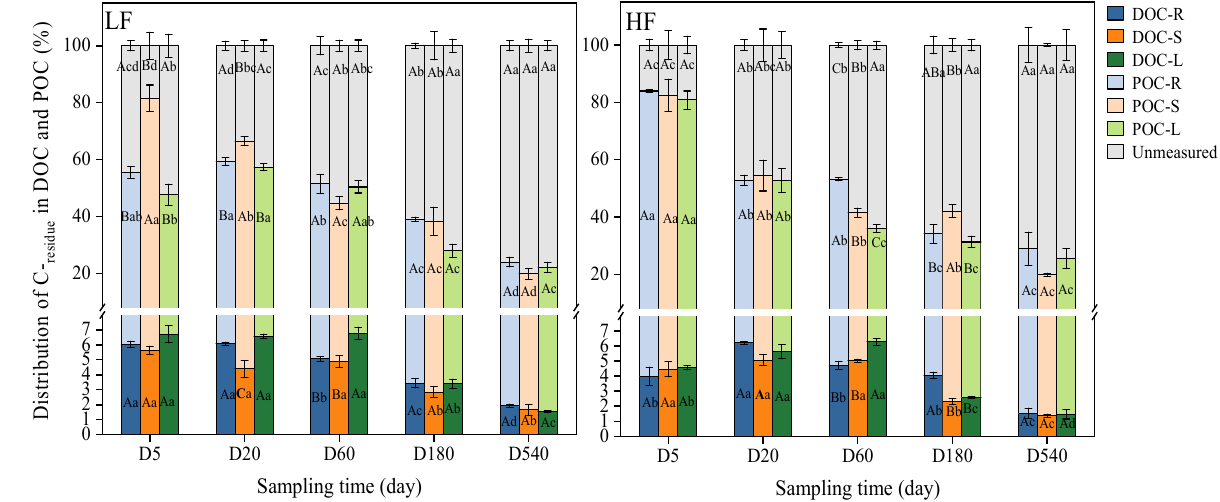
Figure 5. Distribution of C-residue in DOC and POC (%) under di ff erent treatments over 540 days of the experiment. LF and HF indicate low- and high-fertility soils. R, S and L indicate the residues of root, stem and leaf. Error bars represent the standard deviations from the mean (n = 3). Di ff erent uppercase le tt ers indicate signi fi cant di ff erences between di ff erent treatments in the same sampling time, while di ff erent lowercase le tt ers indicate signi fi cant di ff erences between di ff erent sampling times in the same treatment ( p < 0.05). Table 2. ANOVA a nalysis for the e ff ect of sampling time (S), fertility (F) and residue type (R).